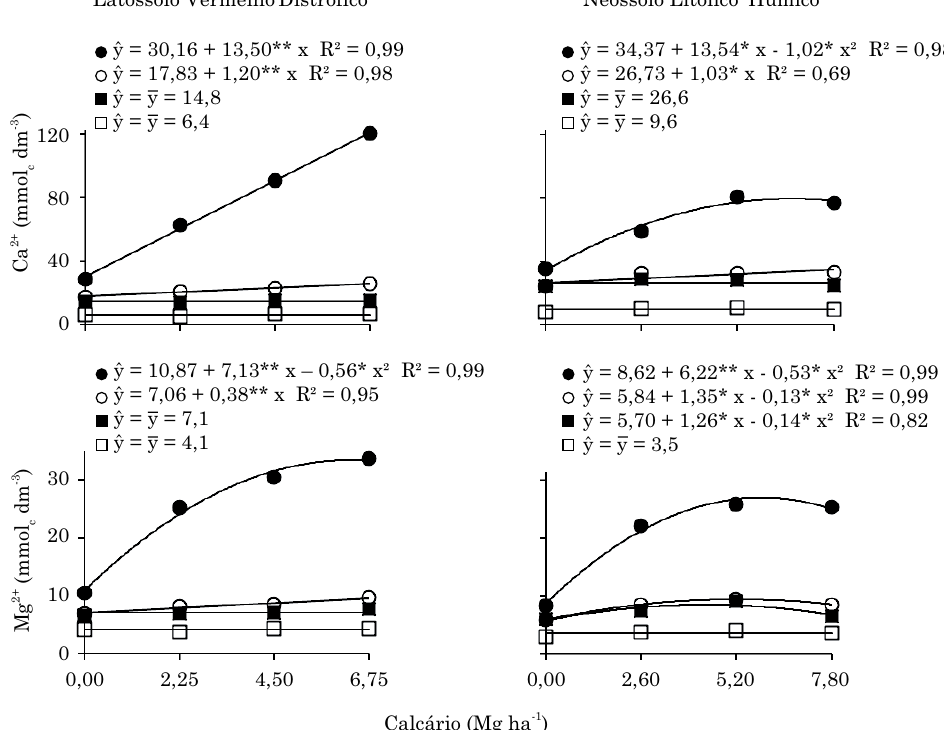
Figura 4. Alterações nos teores de Ca e Mg trocáveis do Latossolo Vermelho Distrófico e do Neossolo Litólico Húmico, nas profundidades de 0,00-0,05 m (●); 0,05-0,10 m (○); 0,10-0,20 m (■) e 0,20-0,40 m (□), considerando as doses de calcário aplicadas na superfície em sistema plantio direto. Os valores são médias de duas fontes de calcário (dolomítico e calcítico) e duas faixas de prnt (B e d). A calagem foi realizada em agosto de 2010, e as amostras de solo foram coletadas em agosto de 2011. * e **: significativo a 5 e 1 %,